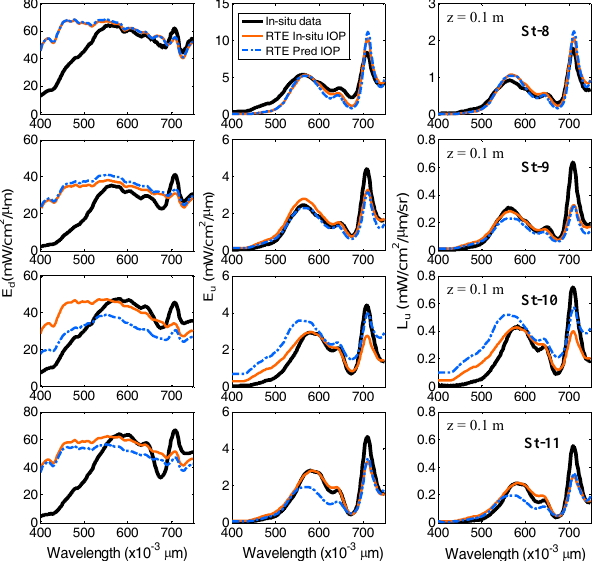
Figure 15. Spectral comparisons of the simulated and measured un- derwater light fields ( E d , E u and L u ) just below the surface in eu- trophic waters off Chennai (St-8–11). The black colour represents the measured data, orange colour represents results from the present RT model using in situ IOP data, and the blue colour represents re- sults from the present RT model using the predicted IOPs from the remote-sensing reflectance